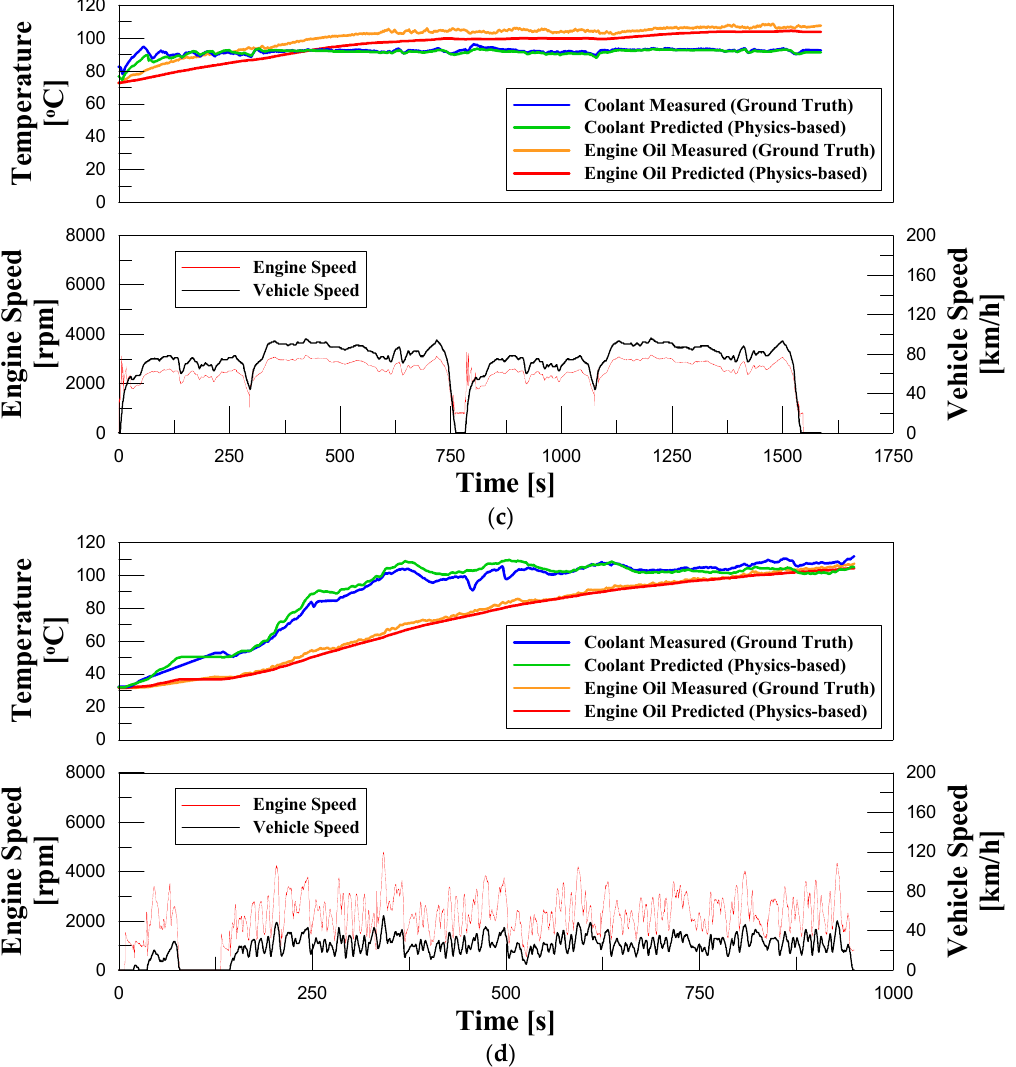
Figure 9. Coolant and engine oil temperatures for various driving conditions predicted by physics-based modeling. ( a ) EPA Federal Test Procedure (FTP-75) Phase 1,2; ( b ) Worldwide harmonized Light duty driving Test Cycle (WLTC); ( c ) Highway Fuel Economy Test cycle (HWFET); ( d ) On-road test.